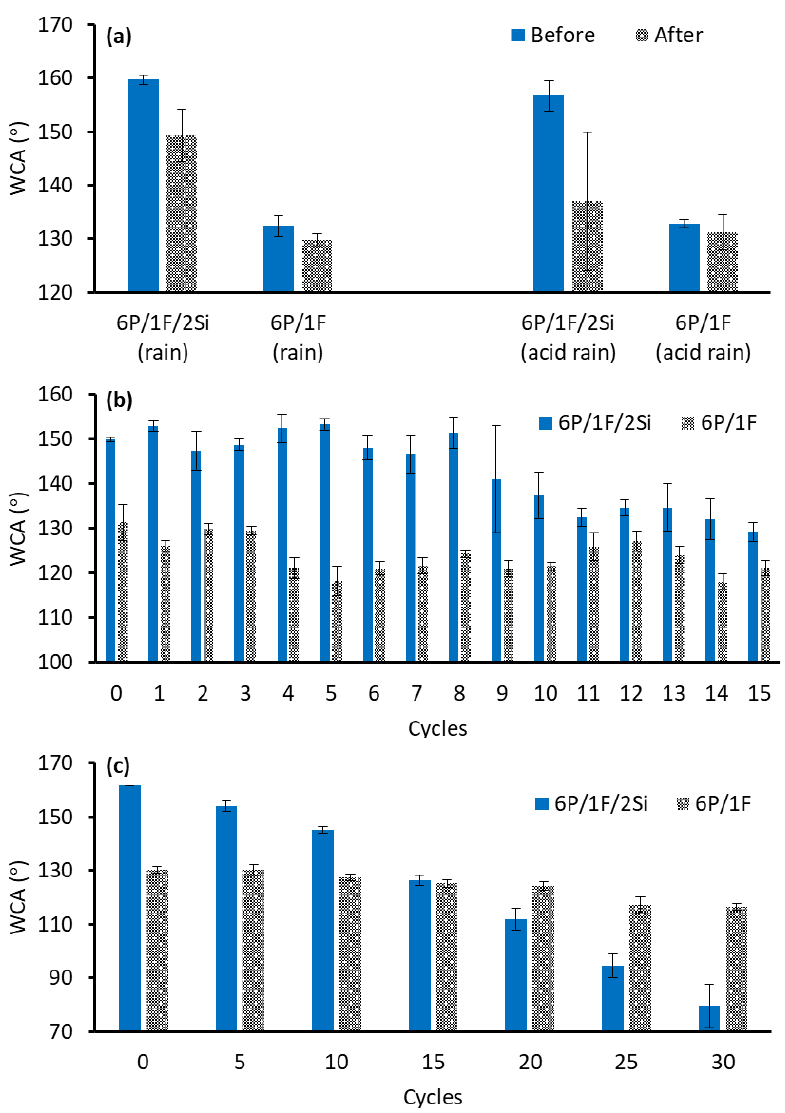
Figure 9. Results for 6P/1F/2Si and 6P/1F surfaces are shown as follows. ( a ) WCA before and after the rain and the acid rain simulation test. ( b ) WCA for several freezing and thawing cycles. ( c ) WCA for several tape peeling cycles.